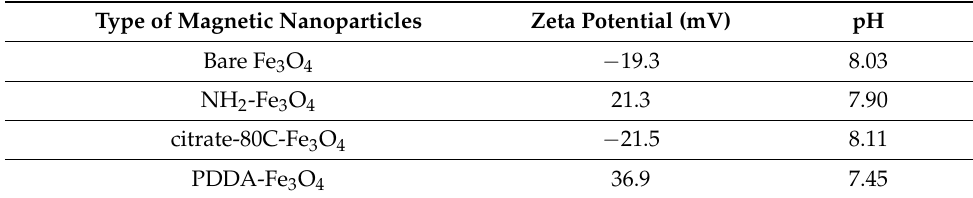
Table 4. Zeta potential of different magnetic nanoparticles.